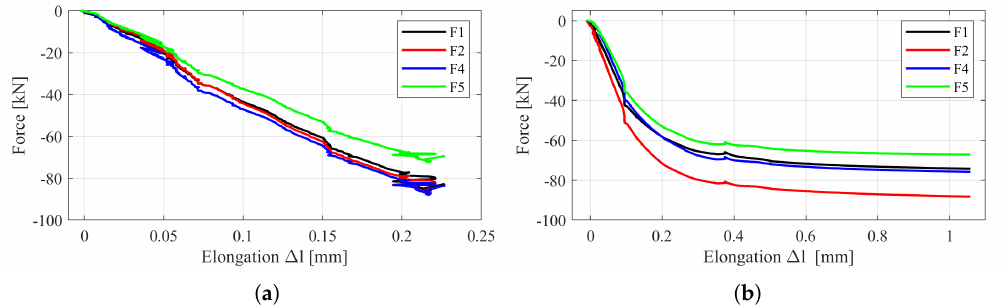
Figure 5. Elongation and forces measured in the bolts: ( a ) P1 connection; ( b ) P2 connection (see Table